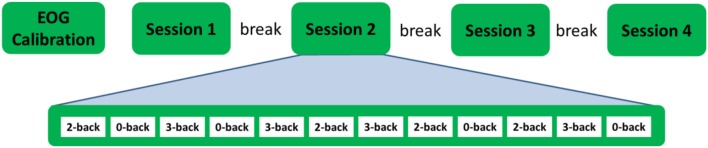
Experiment outline.